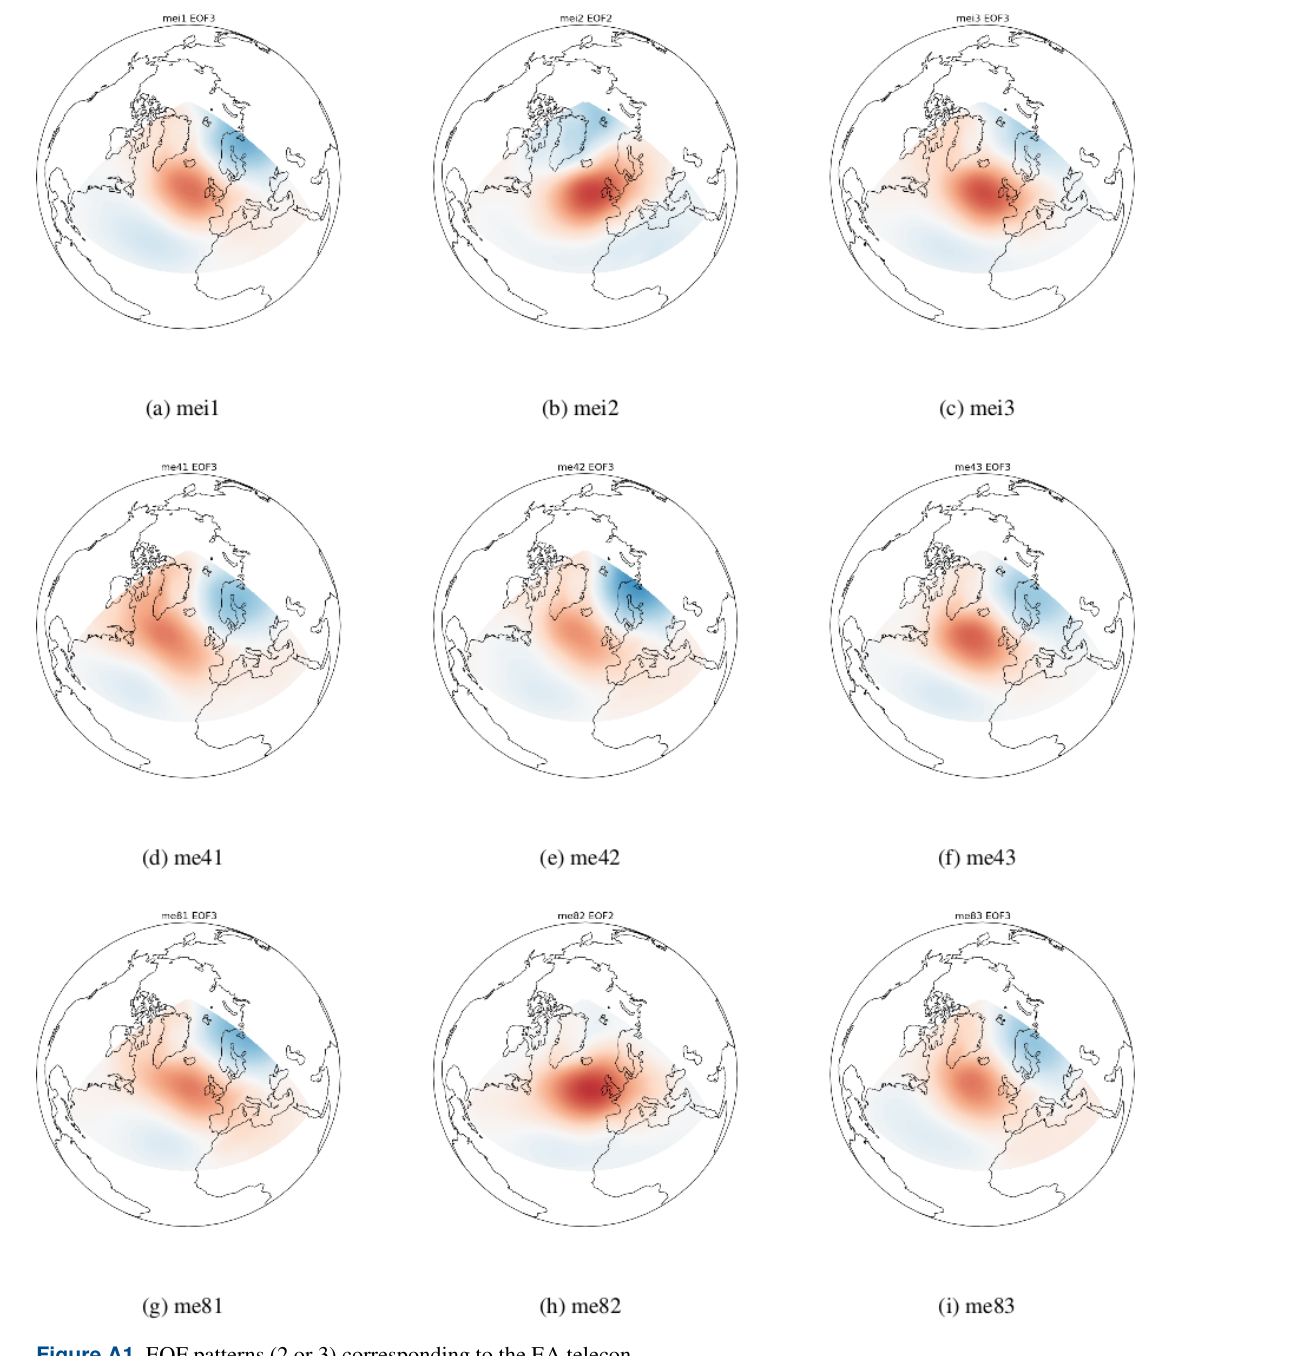
Figure A1. EOF patterns (2 or 3) corresponding to the EA telecon- nection for the EC-Earth historical and future periods under RCP4.5 and